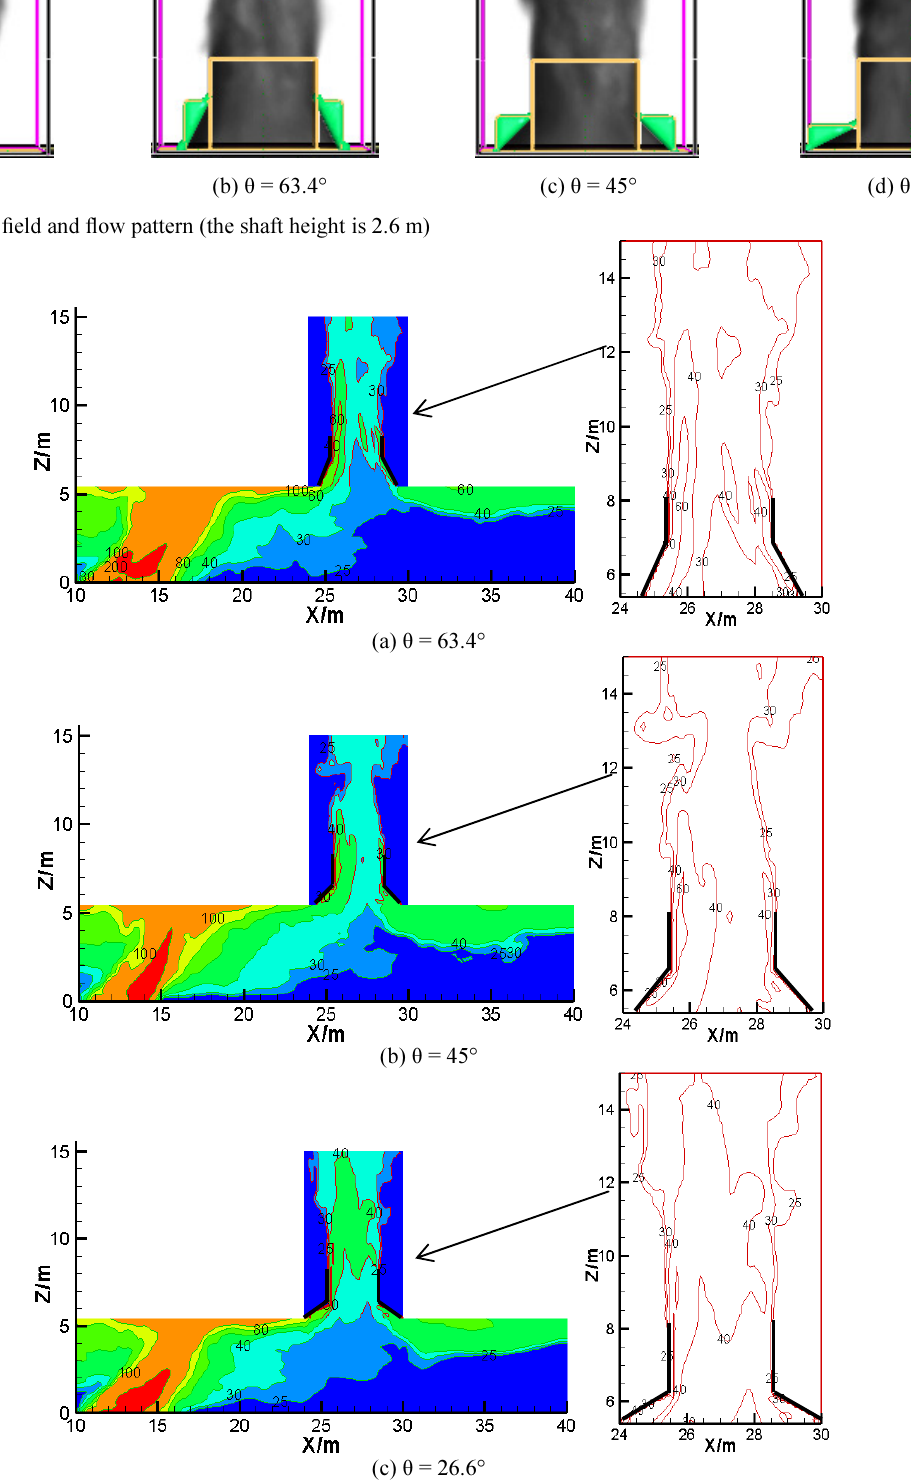
Fig. 10. Temperature field in the shaft and tunnel (the shaft height is 2.6